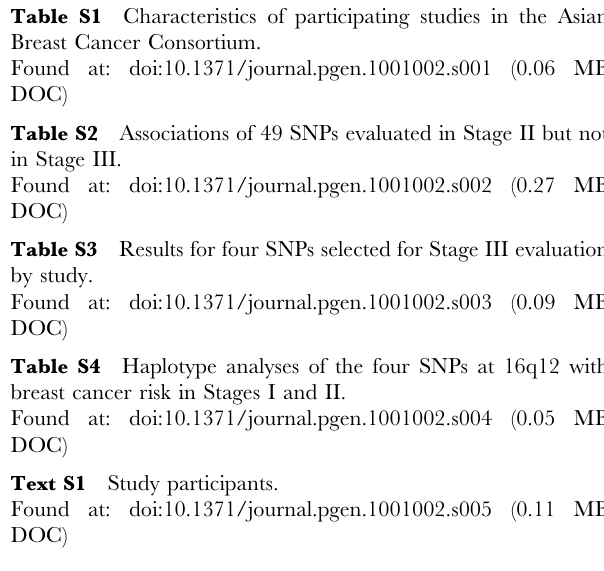
Table S1 Characteristics of participating studies in the Asian Breast Cancer Consortium.